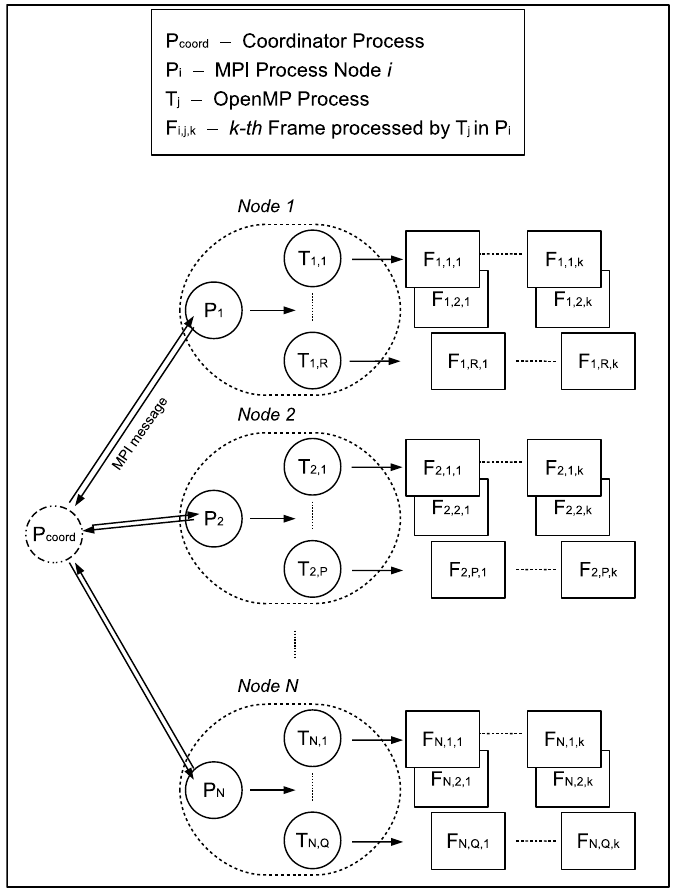
Figure 9. DSM-AI parallel